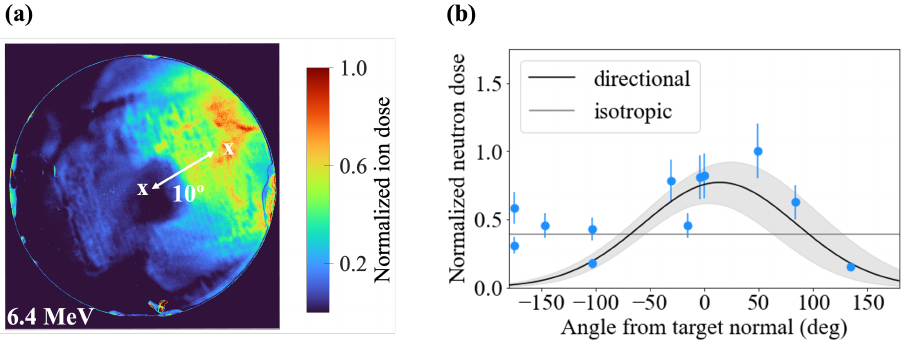
Figure 9. ( a ) Deuteron signal on first RCF layer within the converter at a depth equivalent to 6.4 MeV. ( b ) Neutron signal shown in bubble detector map in laser plane with two curves for the directional and isotropic neutron emission components to guide the